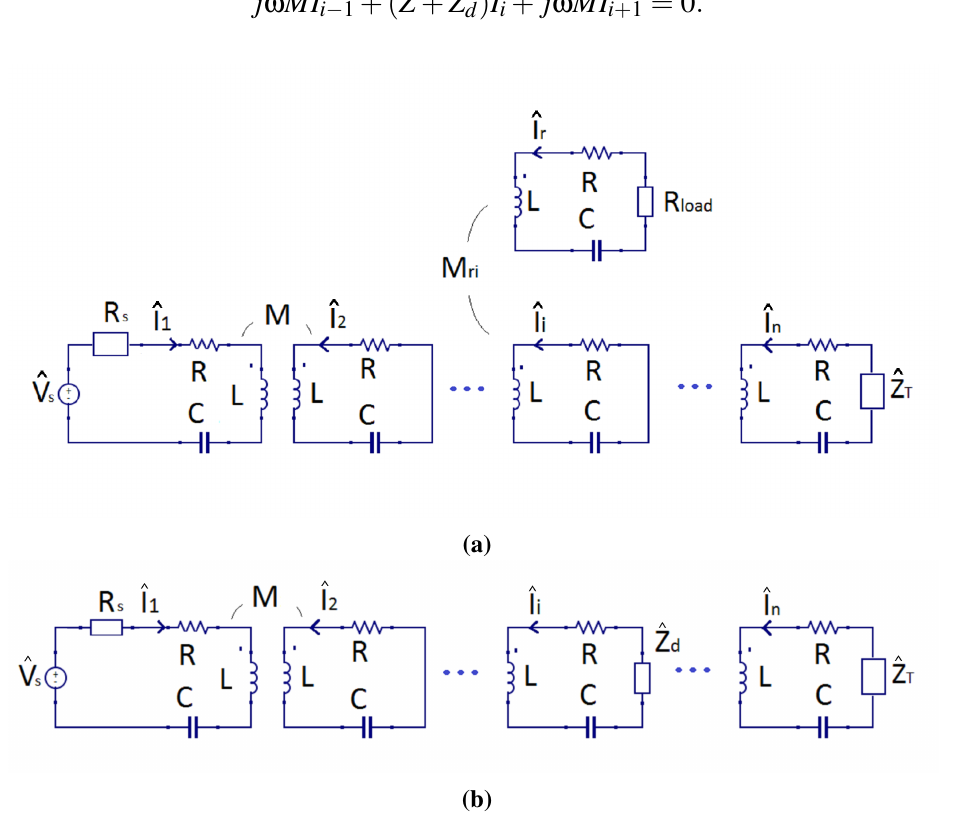
Figure 3. Equivalent circuit of a system composed of n resonator cells with a receiver ( a ) and with the impedance Z ( b d